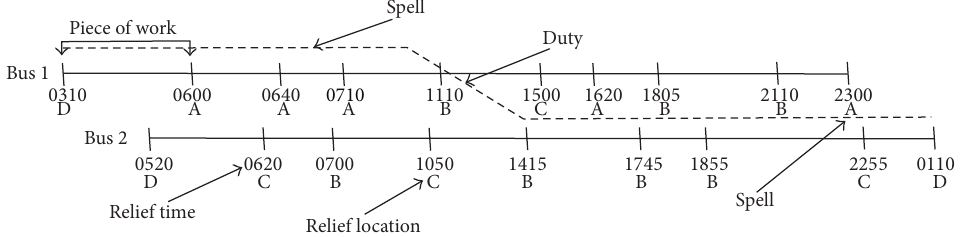
Figure 1: Relationship in vehicle